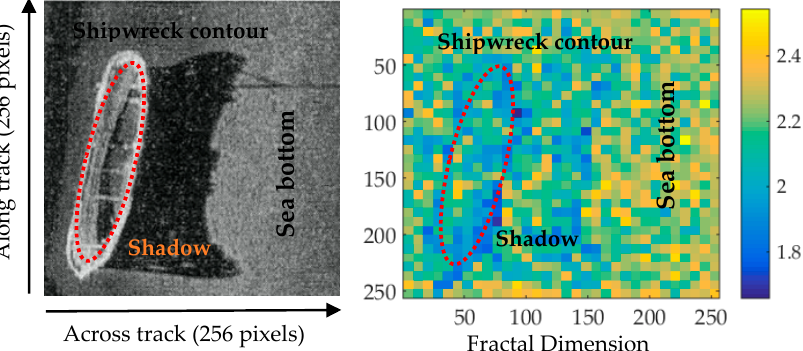
Figure 6. Shipwreck image and its fractal dimension ( D ), the raw SSS image is referenced from [33]. The red ellipse marked area demonstrate the shipwreck contour.